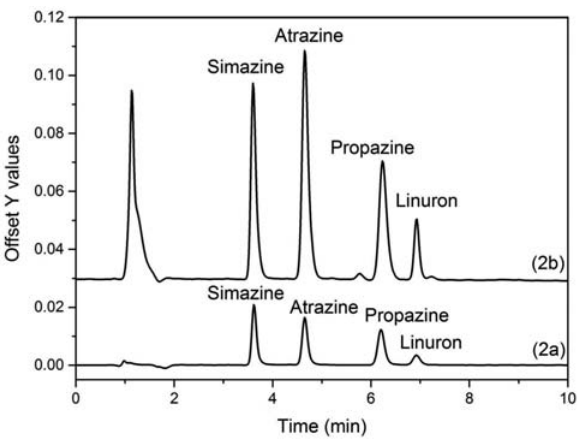
Figure 3. Chromatogram of (a) orange sample, (b) orange sample spiked at 10 μg kg –1 of each herbicide, (c) orange sample spiked at 50 μg kg –1 of each herbicide, and (d) orange sample spiked at 100 μg kg –1 of each